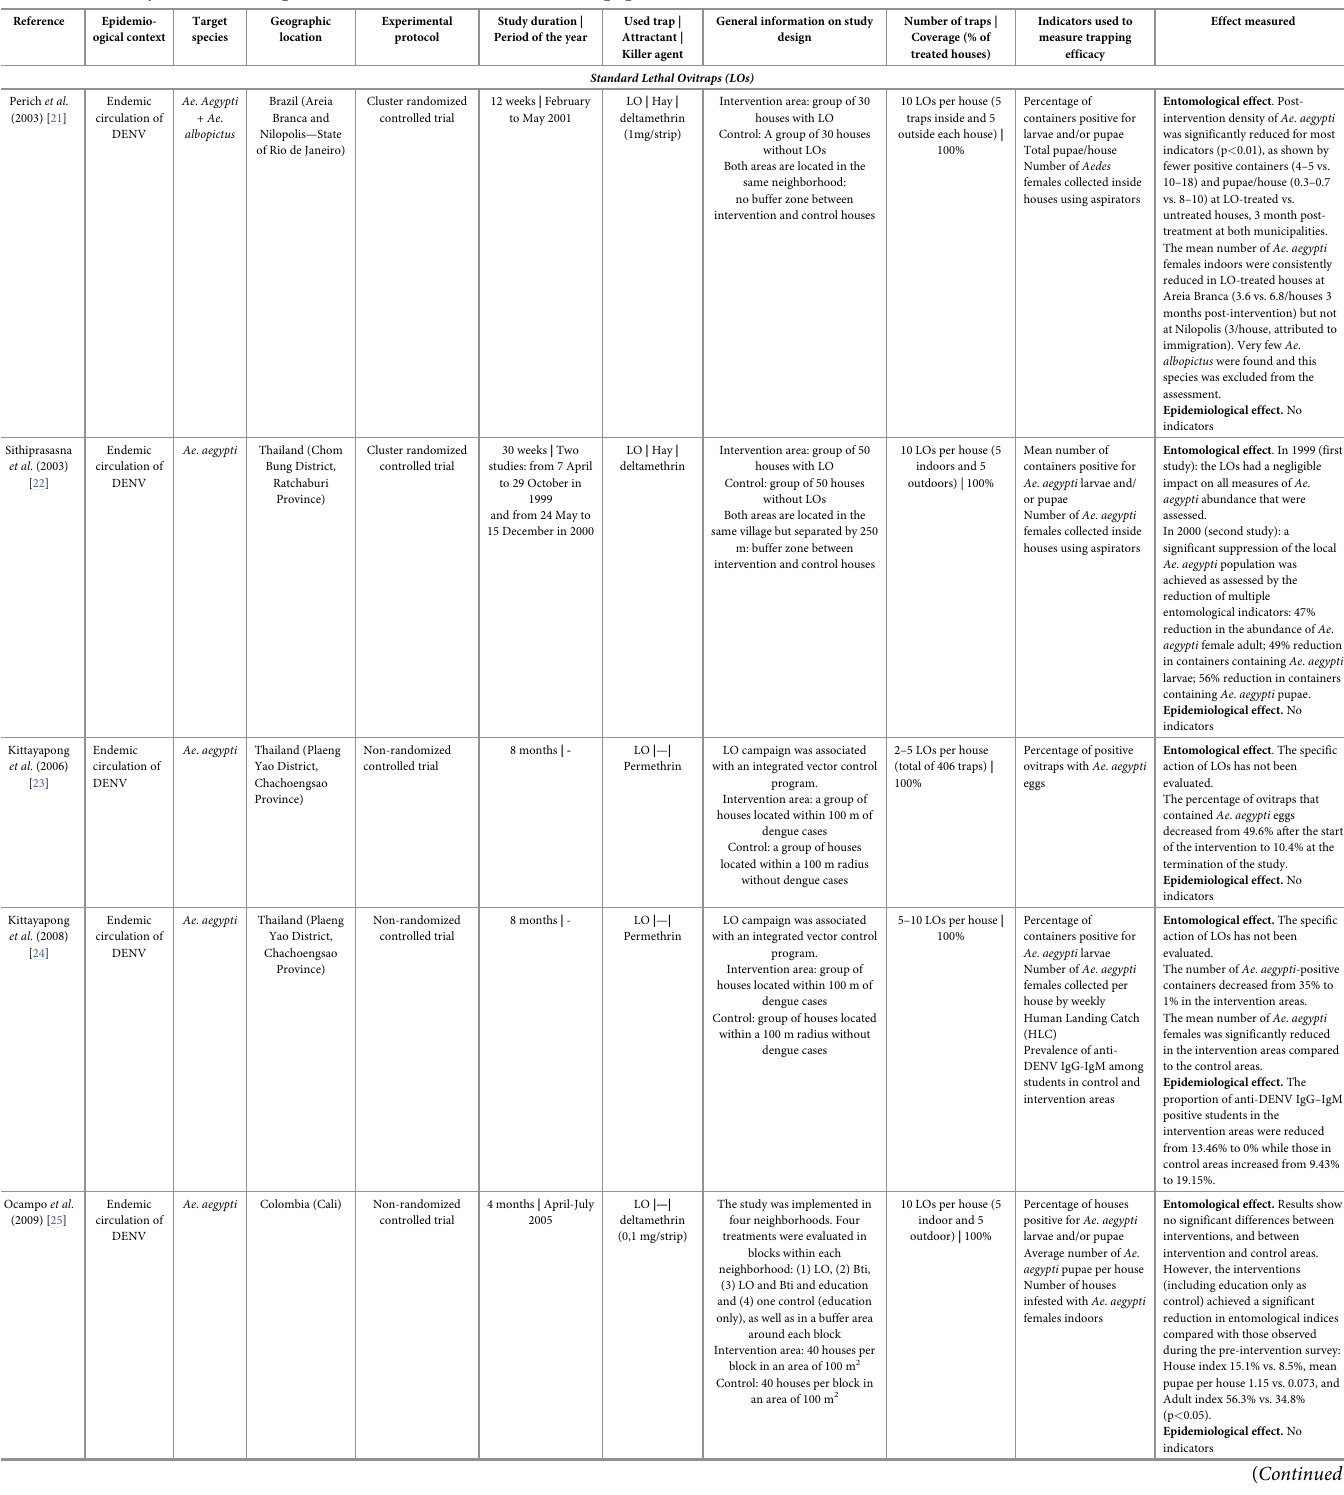
Table 3. Summary of lethal ovitrap-based interventions to control Aedes populations.